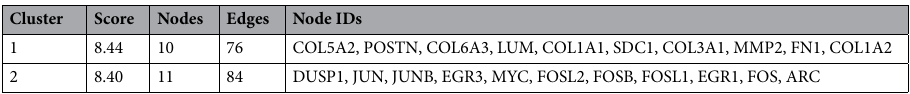
Table 4. Two modules selected from the PPI network. Score=density × no. of